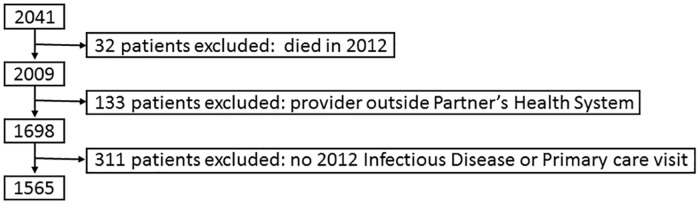
Cohort Development.The flowchart indicates specific exclusion criteria applied in a stepwise manner to develop the final cohort for the study.